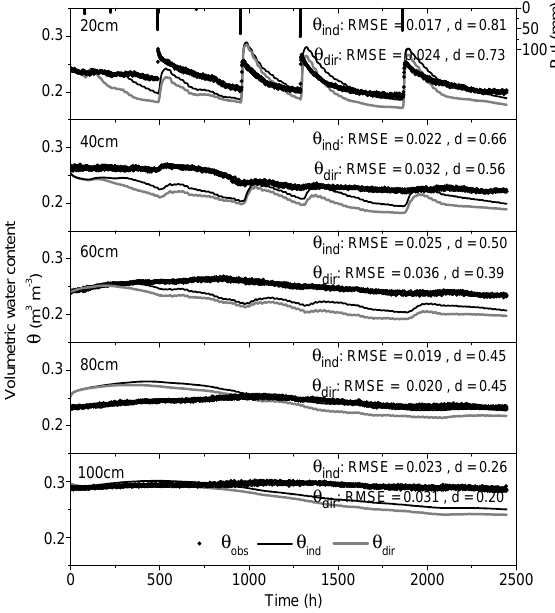
Figure 3. Comparison of observed and simulated soil volumetric water content, at selected depths: 20, 40, 60, 80, and 100cm, with measured precipitation and irrigation (the solid black bar with the right axis of “ P + I (mm)”). The (connected) black dots represent measurements, the black line depicts the simulation using the ET ind method, and the gray line depicts the simulation using the ET dir